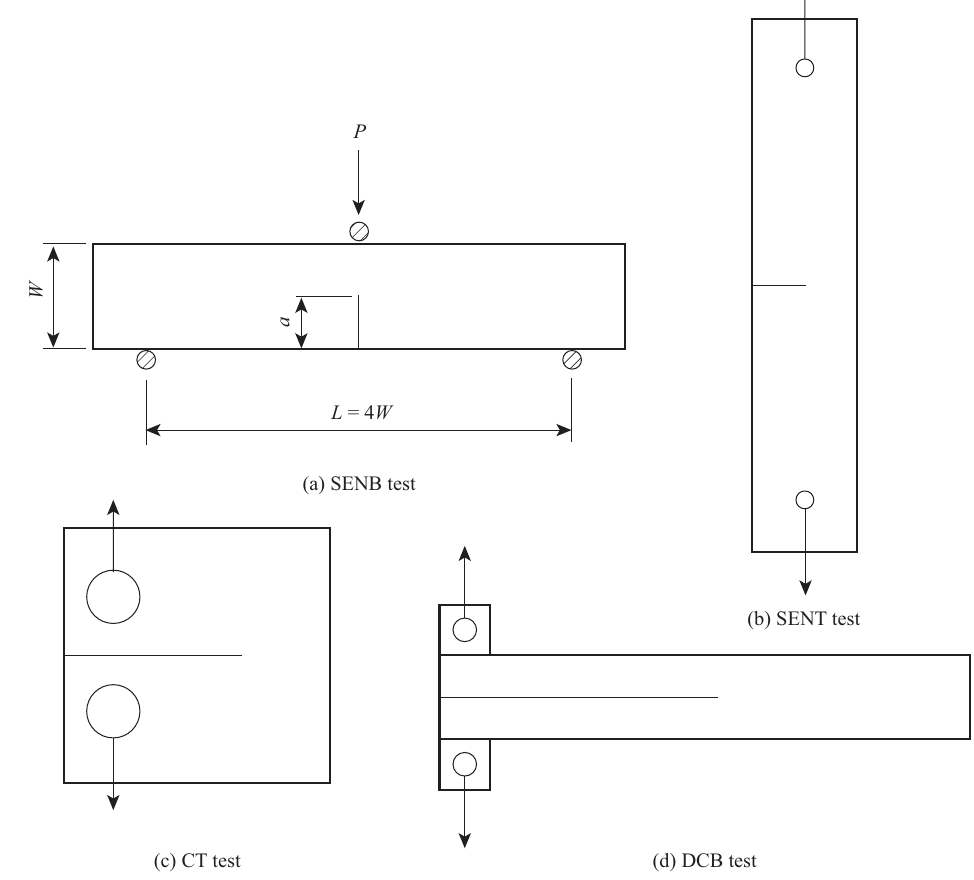
Figure 1 Typical Mode I fracture